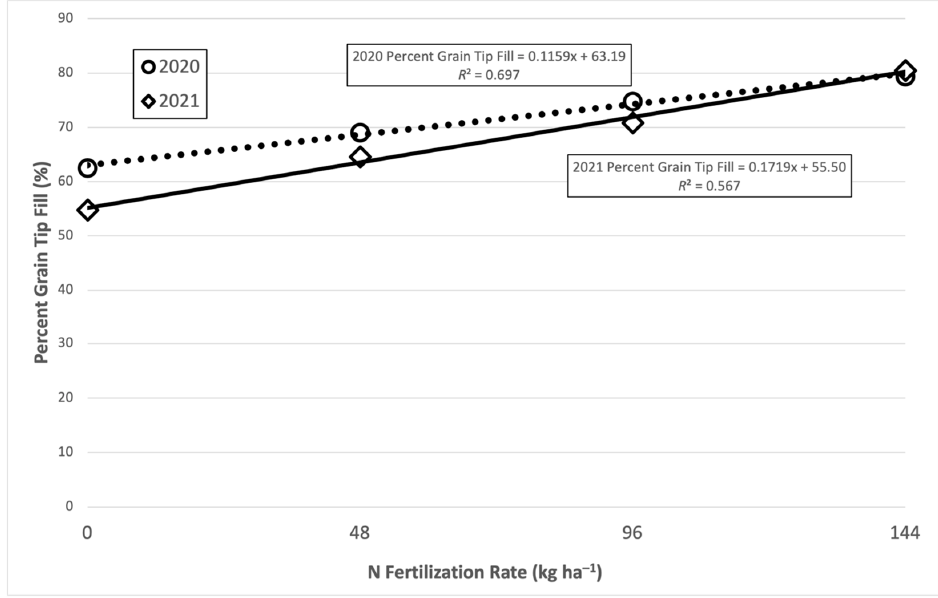
Figure 5. Mean sweet corn percent grain tip fill as a function of N fertilization rate in 2020 and 2021. Goodness of fit described with conditional R 2 .